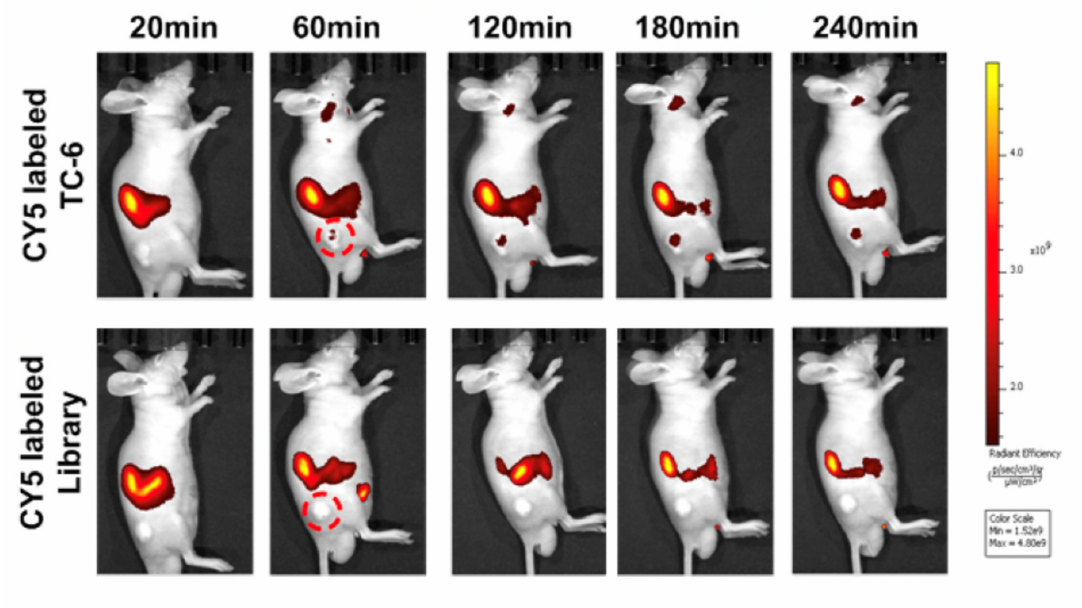
Figure 14. Time-lapse fluorescence imaged post-injection of Cy5-labeled TC-6 ( upper ) or library control ( lower ) in a TPC1 xenograft model. Reproduced with permission from [16], copyright 2016 American Association for Cancer Research.